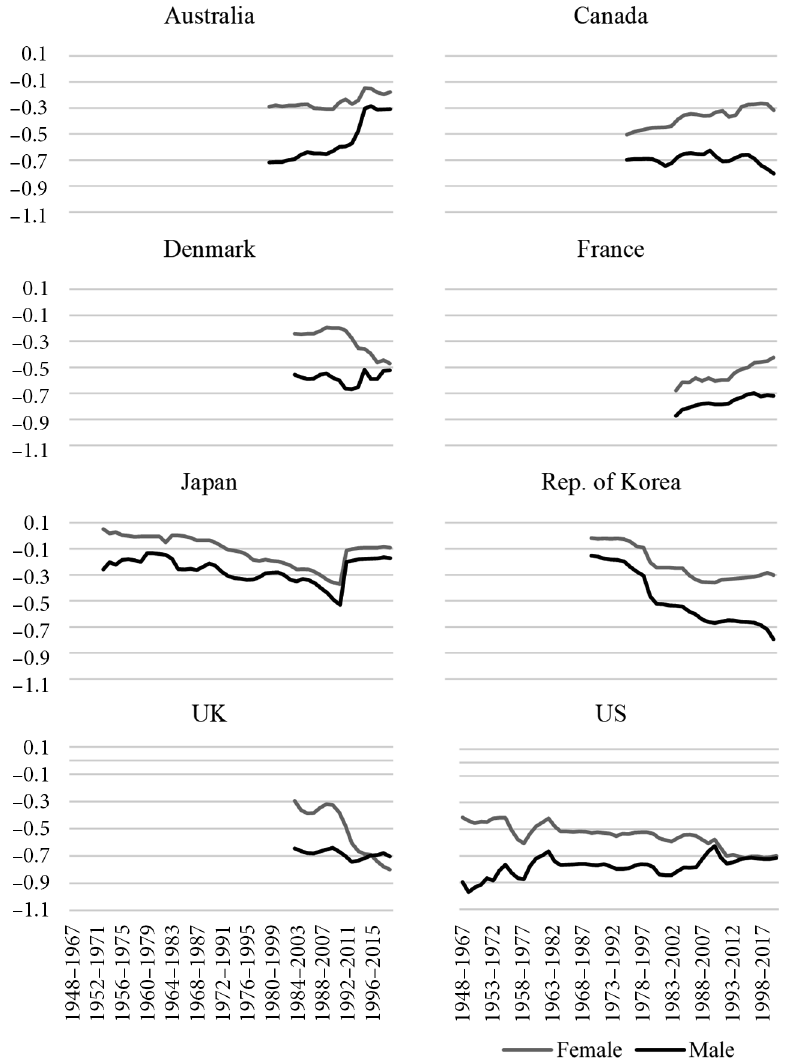
Figure 1. Coefficients of moving regression of a change in a number of unemployed against a change in a number of working persons (model 4, deviations from the trend, moving regression for 20-year periods) (source: own calculations based on the ILO